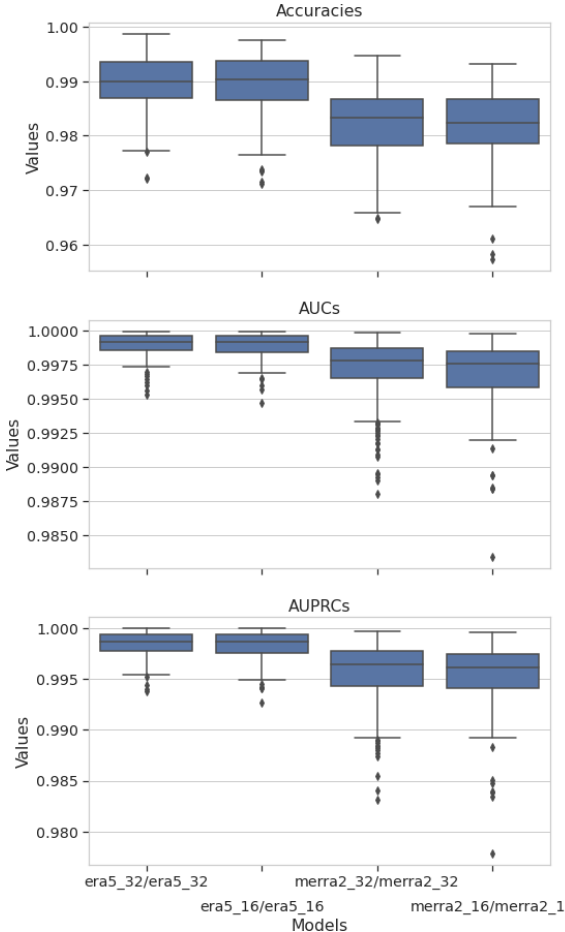
Figure 8. Box plots of the accuracy, the AUC, and the AUPRC metric values for the CNN for the four image sets. The models are tested against the same image set as they are trained against (e.g., era5_32/era5_32 means the CNN was trained and tested on ERA5 native). Box plots are a synthetic representation of a data distribu- tion. They are composed of a box and two whiskers. The bottom of the box corresponds to the first quartile ( Q 1 ) of the studied dataset, below which 25% of the data are located. The middle line of the box is the median of the dataset, and the top line of the box cor- responds to the third quartile ( Q 3 ), below which 75% of the data are located. The interquartile range is represented by the extent of the box: IQR = Q 3 − Q 1 . The bottom whisker is calculated accord- ing to the IQR Q 1 − 1 . 5 × IQR and the top whisker according to Q 3 + 1 . 5 × IQR. The data outside the whiskers are regarded as out- liers and are represented by diamond